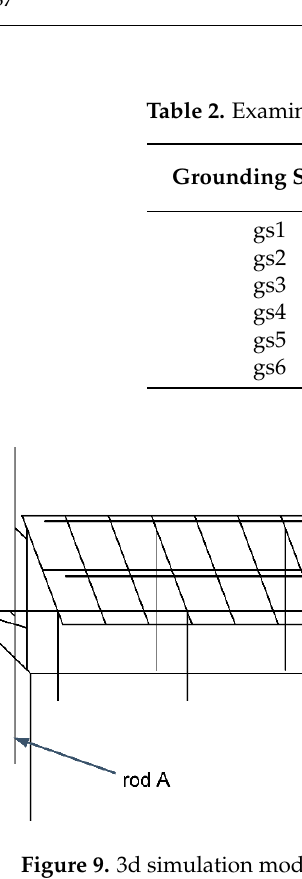
Figure 10. Maximum potential for soil structure D and grounding systems of Table 2. 5. Discussion To achieve an accurate picture of the lightning performance of the system under study, several issues need to be addressed, concerning different parameters (separation